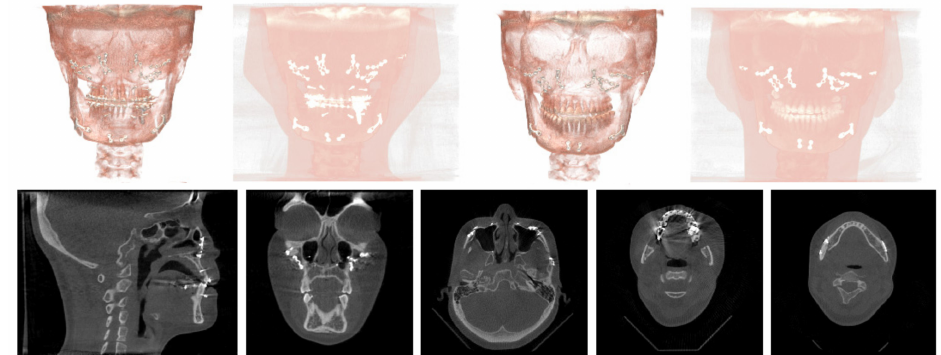
Figure 3. Examples of noises caused by surgical plates, orthodontic device, and dental implants in CenterB dataset, which make it more challenging to delineate the CT